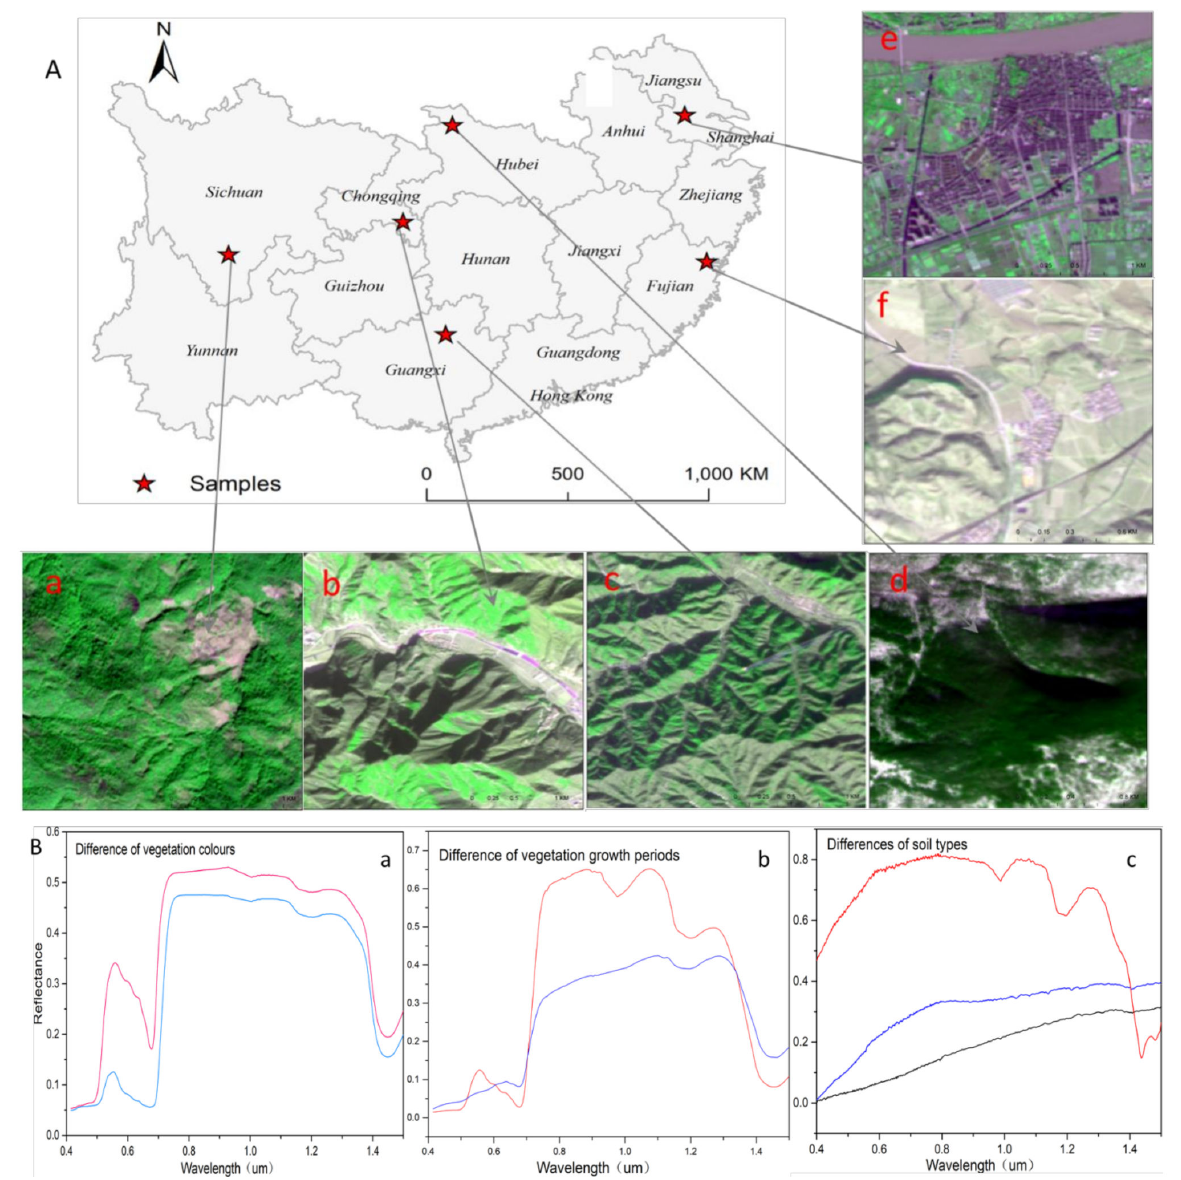
Figure 4. Spatial heterogeneity among vegetation and soil. ( A ) a~f: color contrasts indicate differences among vegetation and soil cover in different regions; ( B ) data from the United States Geological Survey (USGS) Advanced Spaceborne Thermal Emission and Reflection Radiometer (ASTER) spectral library. a and b, reflectance differences between forest with different leaf colors and growth period; c, reflectance difference among three